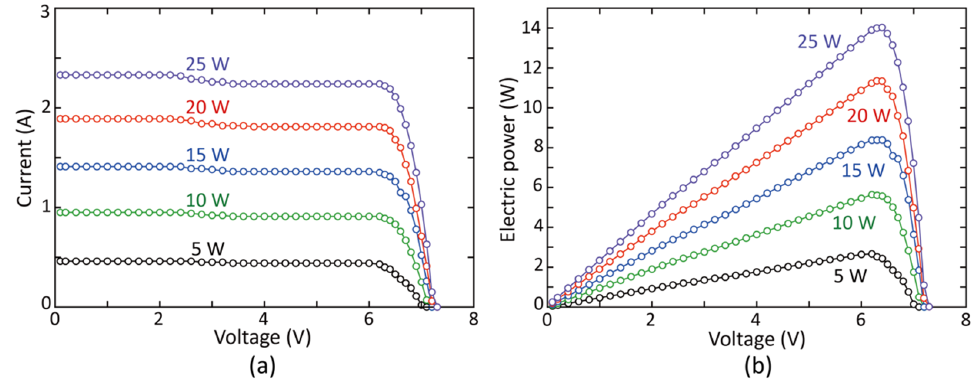
Figure 8. ( a ) IV and ( b ) PV curve characteristics of PPC while changing input optical power.